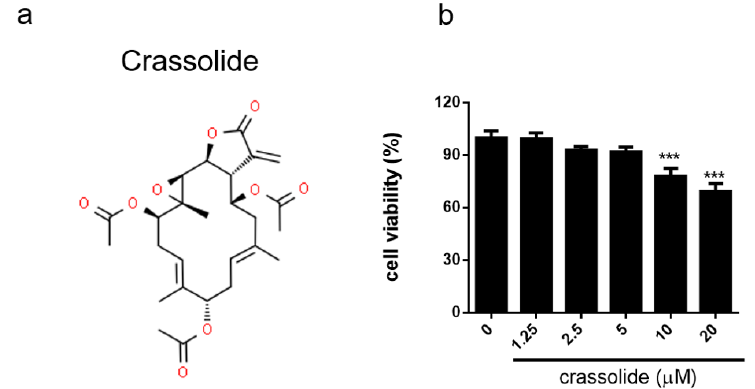
Figure 1. Effects of crassolide on BMDCs cell viability: ( a ) Chemical structure of crassolide. ( b ) Cell viability measured by CCK-8 viability assay after 24 h of crassolide treatment. Data are presented as percentages of the control treated with 0.1% DMSO. Values represent the means ± SEM from one of three independent experiments. *** p < 0.001, versus 0.1% DMSO-treated control group, tested by one-way ANOVA followed by Tukey’s multiple comparison test.